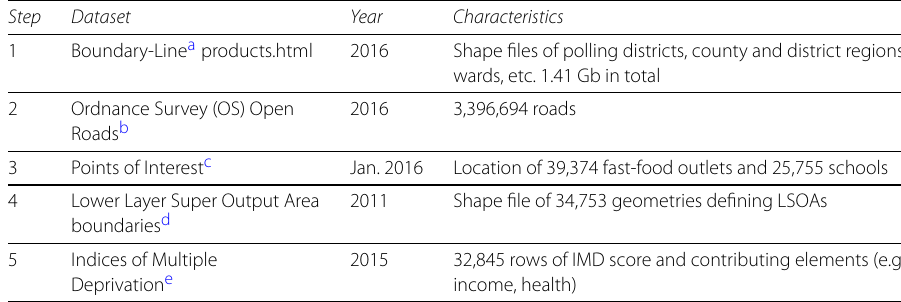
Table 4 Datasets combined for our